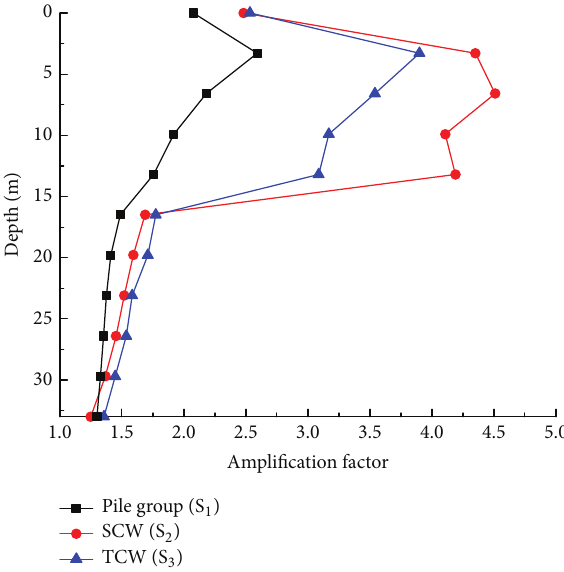
Figure 17: Peak acceleration of inner